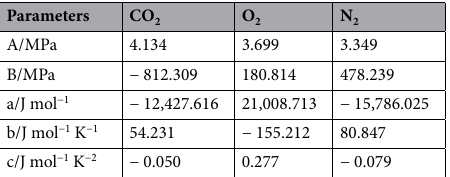
Table 6. Parameters obtained by fitting experimental data.